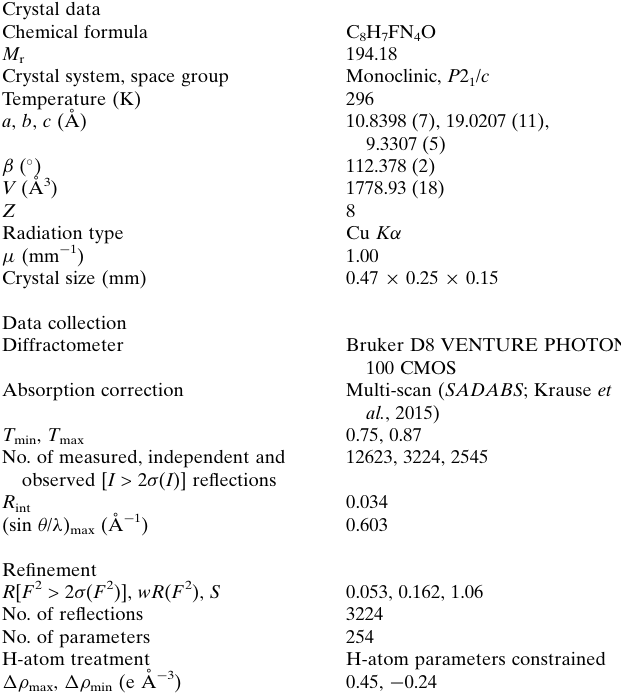
Table 2 Experimental details. Crystal data Chemical